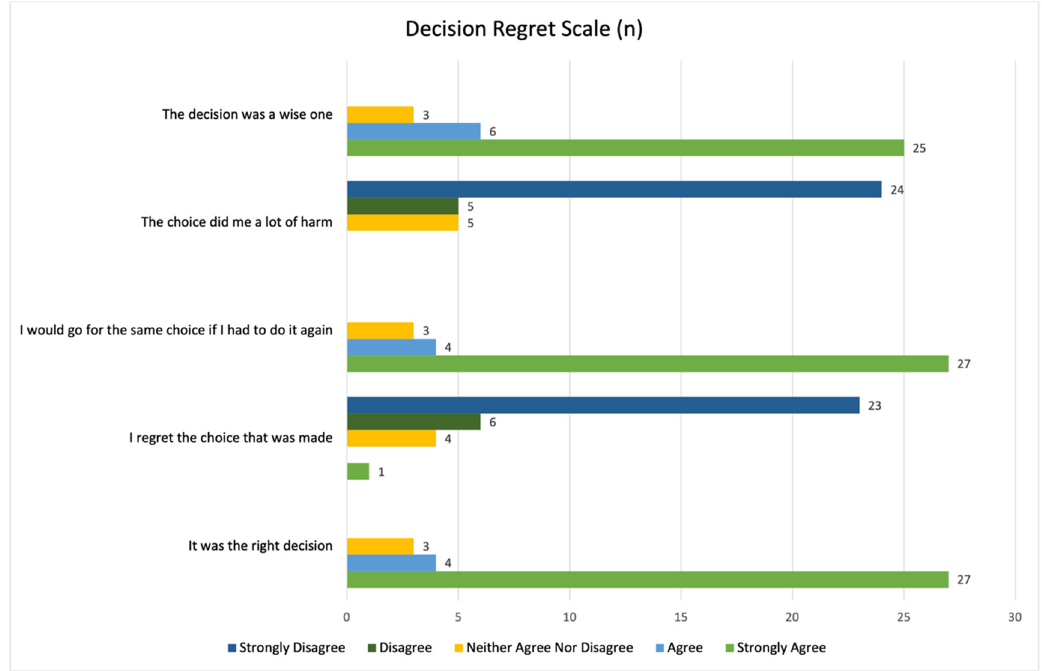
Figure 5. Summary of participant responses to the Decision Regret Scale.